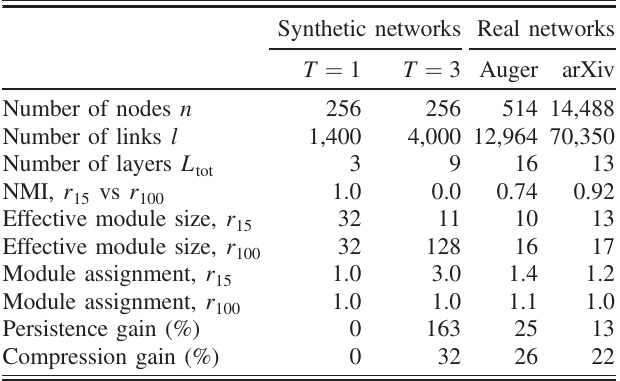
TABLE III. Summary of multilayer effects on community